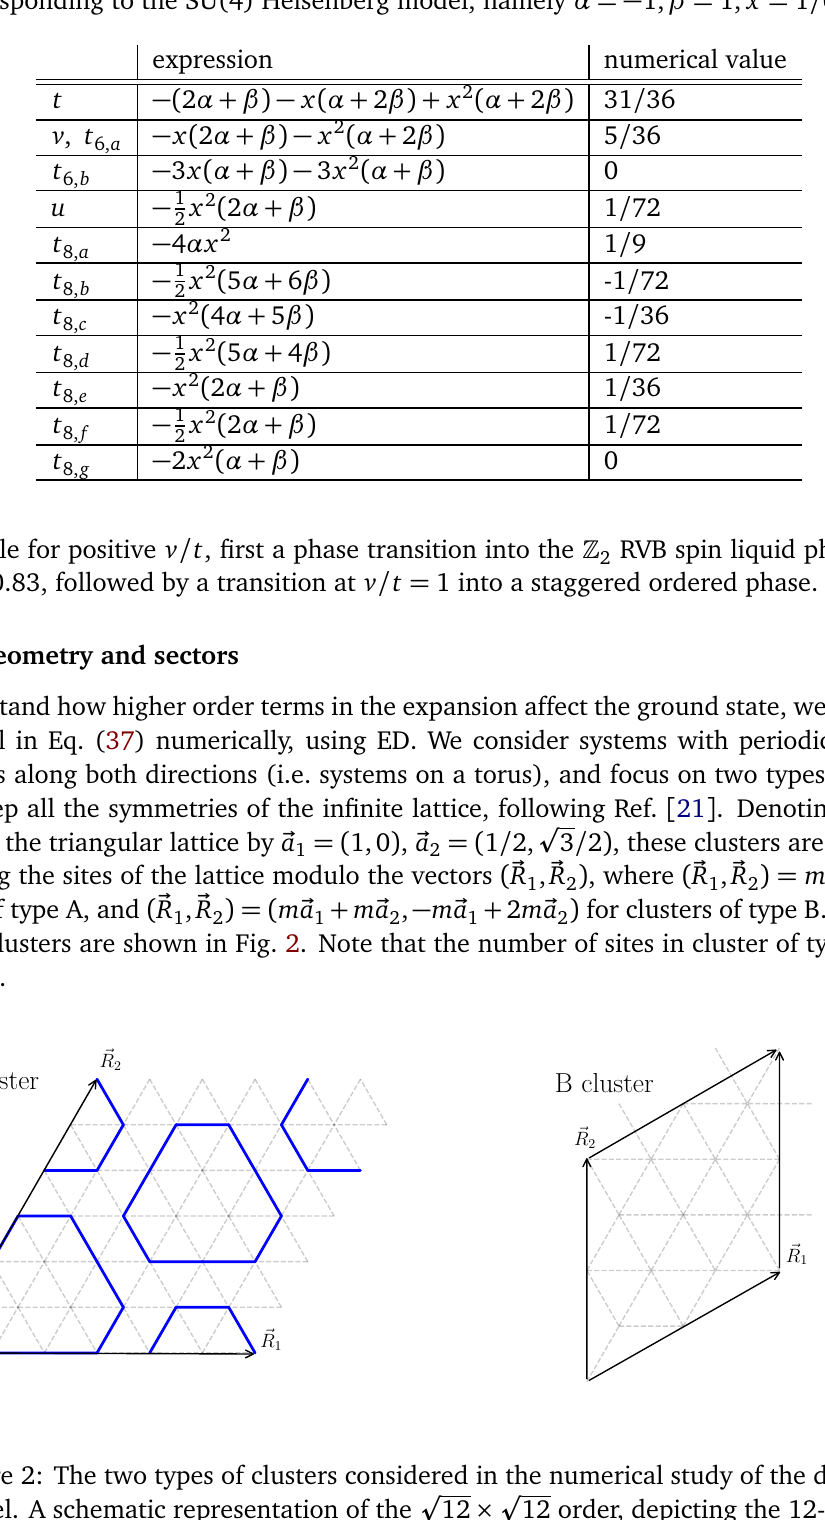
Table 2: Coefficients of the terms in the effective dimer model given in Eq. (37). The numerical value in the last column is calculated for the parameters